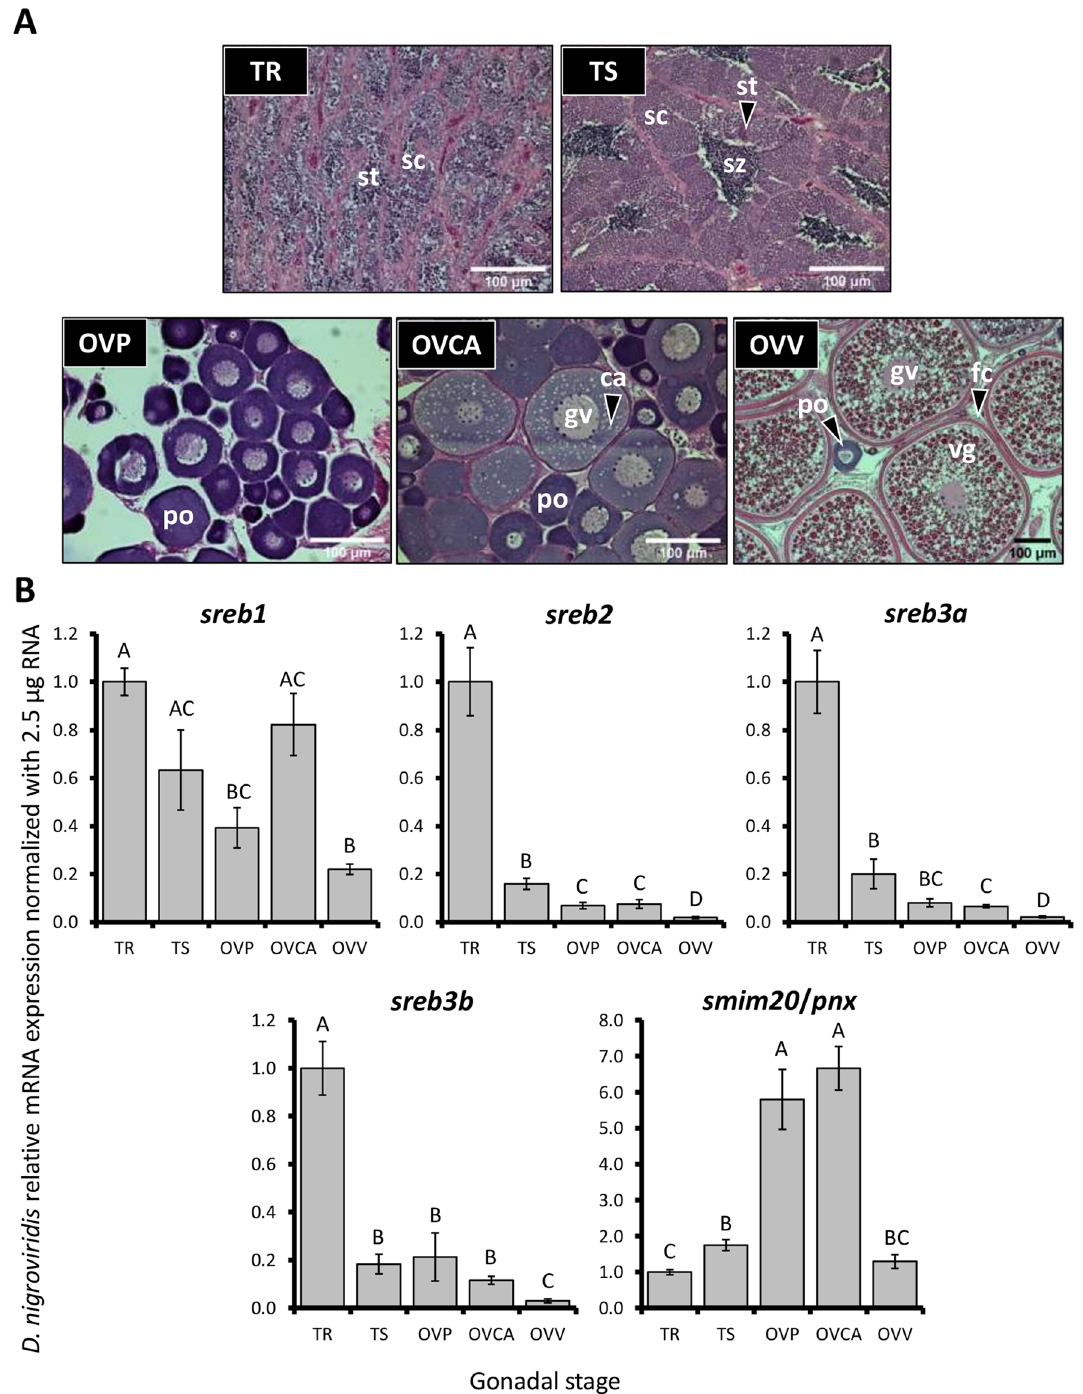
Figure 7. Green-spotted puffer ( Dichotomyctere nigroviridis ) ( A ) representative gonadal histology and ( B ) relative mRNA expression of sreb genes and smim20/pnx , normalized using stable RNA input across samples (2.5 μg). The TR and TS stages refer to regressed testes without spermatozoa and testes with visible spermiation and abundant mature spermatozoa, respectively. The OVP, OVCA, and OVV stages refer to ovaries with primary oocytes, cortical alveoli (early secondary growth) oocytes, or mid-late stage vitellogenic oocytes respectively. Each bar represents the mean ± standard error, and different letters indicate significant differences ( p < 0.05). ca = cortical alveoli (secondary) oocyte, fc = follicle cell wall, gv = germinal vesicle, po = primary oocyte, sc = spermatocytes, st = spermatids, sz = spermatozoa, and vg =